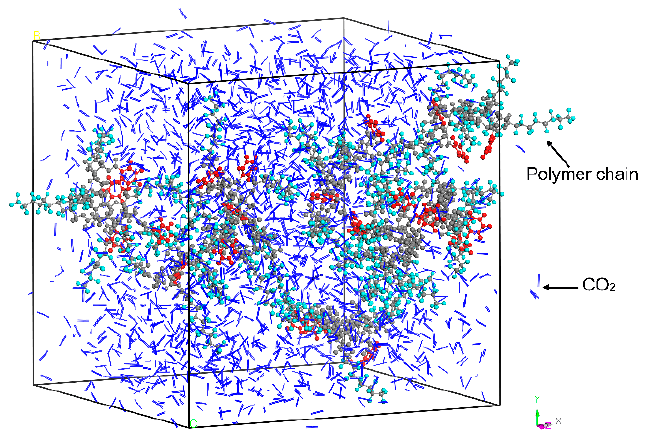
Figure 2. Optimized conformation of the polymer–CO 2 system (CO 2 was marked as blue line molecular; while polymer chain was marked as ball and stick figure).